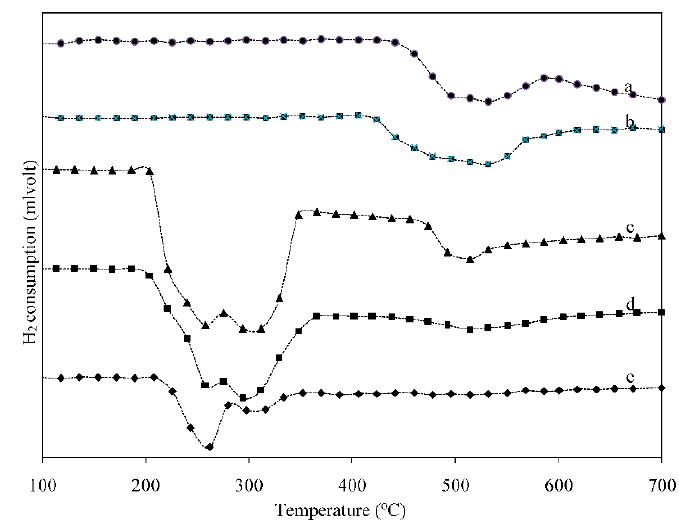
Figure 7. TPR profiles of other catalysts; ( a ) 18 wt. % Ni 0.5 ‐ Mo 0.5 / γ‐ Al 2 O 3 ; ( b ) 18 wt. % Ni 0.5 ‐ Ce 0.5 / γ‐ Al2O 3 ; ( c ) 36 wt. % Ni 0.5 ‐ Cu 0.5 / γ‐ Al 2 O 3 ; ( d ) 18 wt. % Ni 0.5 ‐ Cu 0.5 / γ‐ Al 2 O 3 ; ( e ) 6 wt. % Ni 0.5 ‐ Cu 0.5 / γ‐ Al 2 O 3 . Table 2. Summary of H 2 ‐ Temperature program reduction (TPR) of different catalysts.